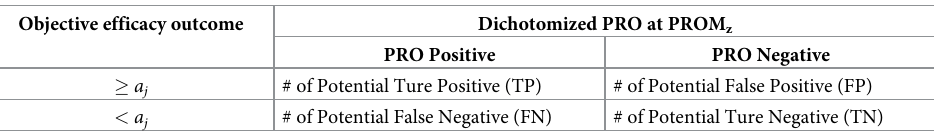
( j = 1, ... , m ) for subject i and PROM z j